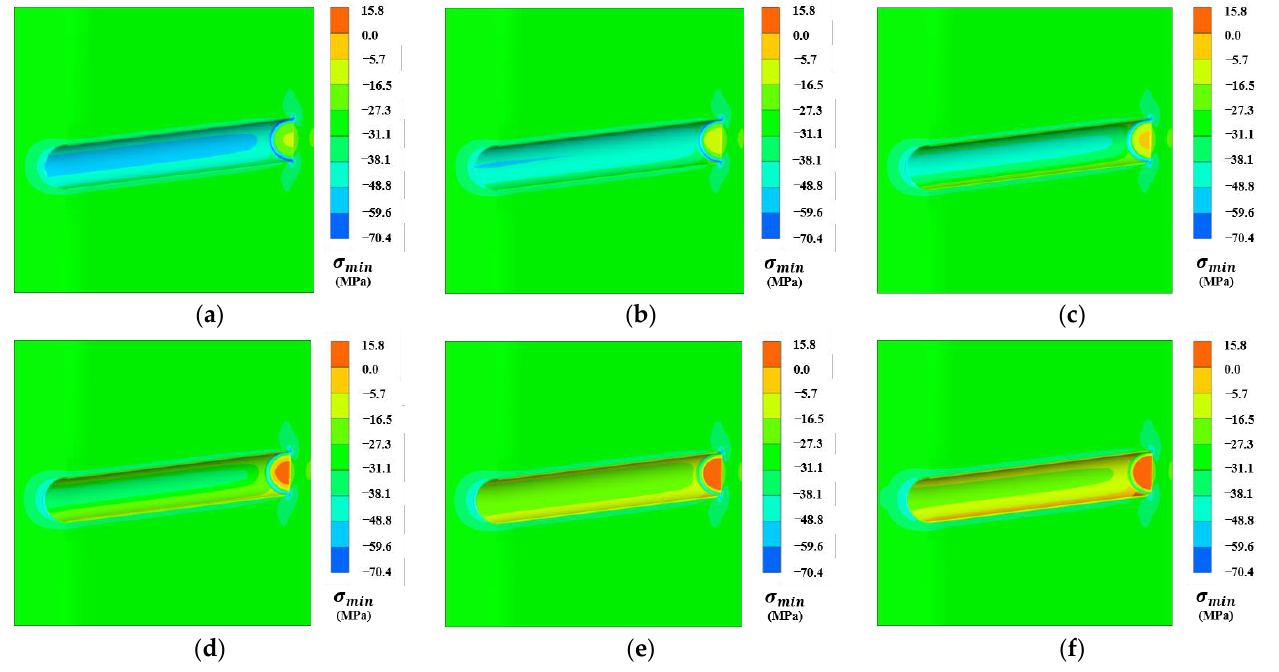
Figure 8. Magnitude and distribution of the minimum principal stress at t = 0~24 h in the tunnel. ( a ) t = 0 h; ( b ) t = 1 h; ( c ) t = 3 h; ( d ) t = 6 h; ( e ) t = 12 h; ( f ) t = 24